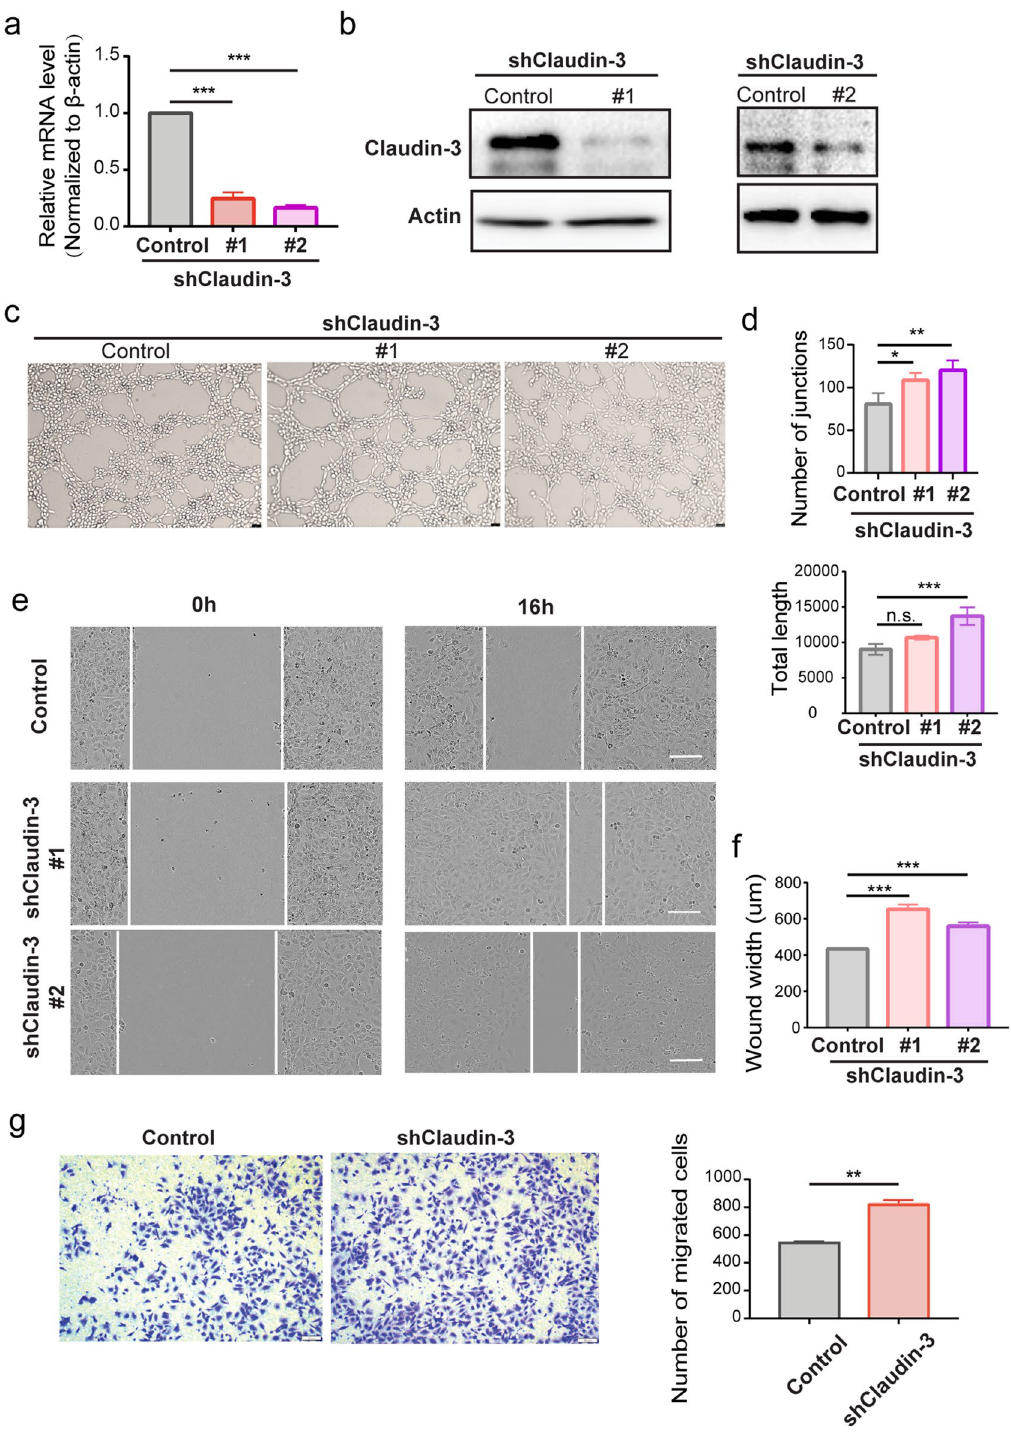
Figure 3. Knockdown of claudin-3 in SVEC4-10 cells promotes cell migration. ( a ) SVEC4-10 cells were transfected with two independent shRNA plasmids to knockdown claudin-3 protein (shClaudin-3-1 & shClaudin-3-2) accompanied with the transfection of control plasmid (Control). RT-PCR analysis was used to examine the mRNA expression in the two knockdown cells compared to control cells. (*** p < 0.001) (n = 3 per group) ( b ) Western blot analysis indicated the knockdown of claudin-3 protein in SVEC4-10 cell. ( c ) Representative images of tube formation of SVEC4-10 cells transfected with shClaudin-3-1, shClaudin-3-2, and control. Scale bar, 100 μm. ( d ) Number of junctions and total length were analyzed as indicators of tube formation ability via the ImageJ. (n.s. no significance, *** p < 0.001) (n = 3 per group) ( e ) Scratching assay was conducted and the photos were taken at 0 h and 16 h under a microscope. Scale bar, 100 μm. ( f ) Wound width was quantified and analyzed. (*** p < 0.01) (n = 5 per group) ( g ) Transwell assay was conducted and the representative images were taken. Scale bar, 100 μm. Cells on the bottom side were counted and analyzed by t-test. (** p < 0.01) (n = 5 per